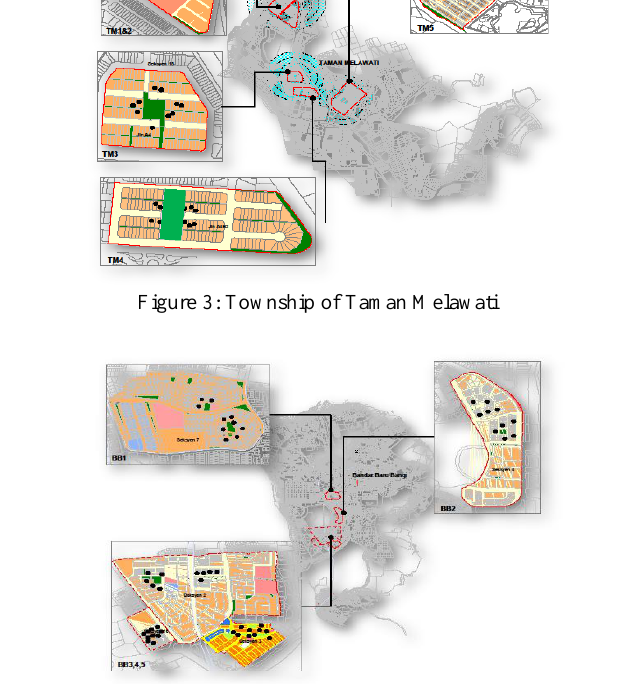
Figure 4: Township of Bandar Baru